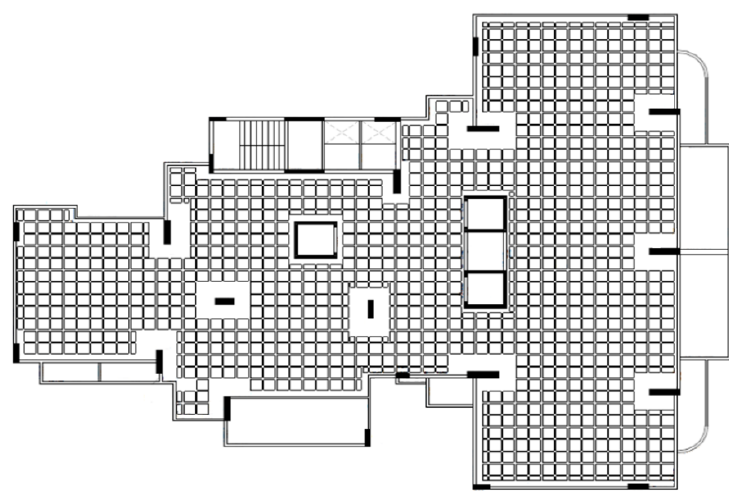
Figure 3. Shear walls arrangement on a building project [6]